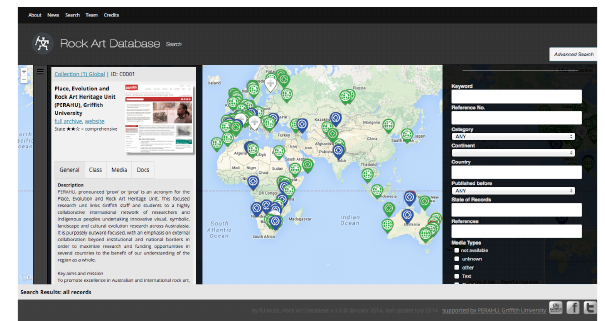
Figure 8. The RADB Management